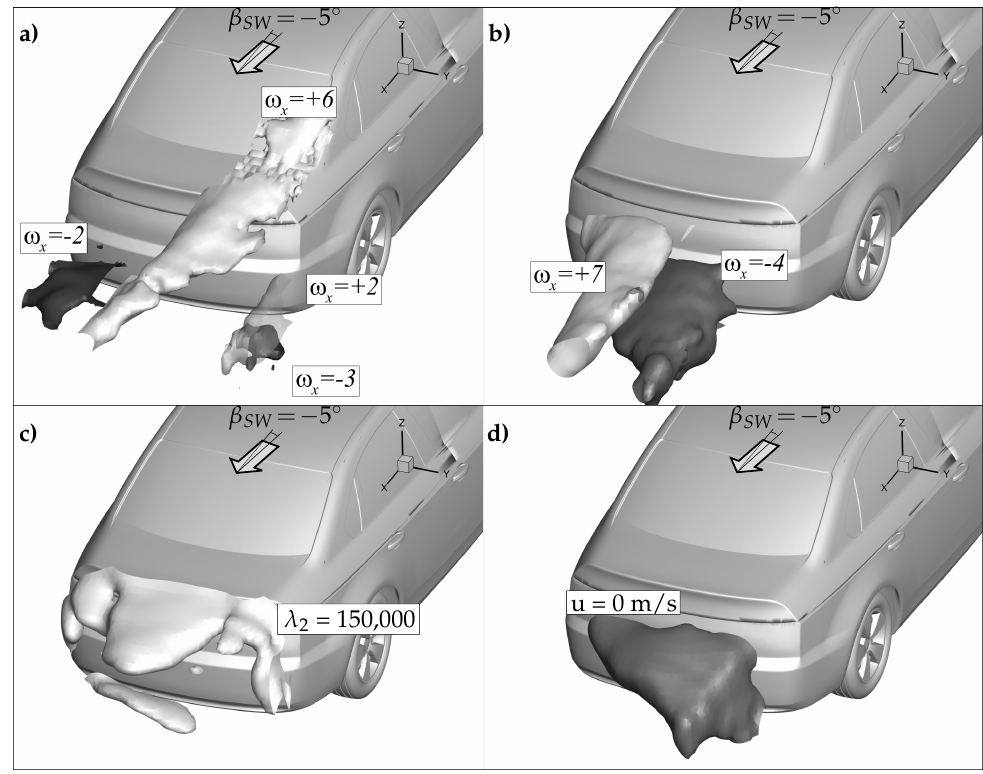
5 ◦ : ( a , b ) streamwise vortices, ( c ) λ 2 -criterion, −